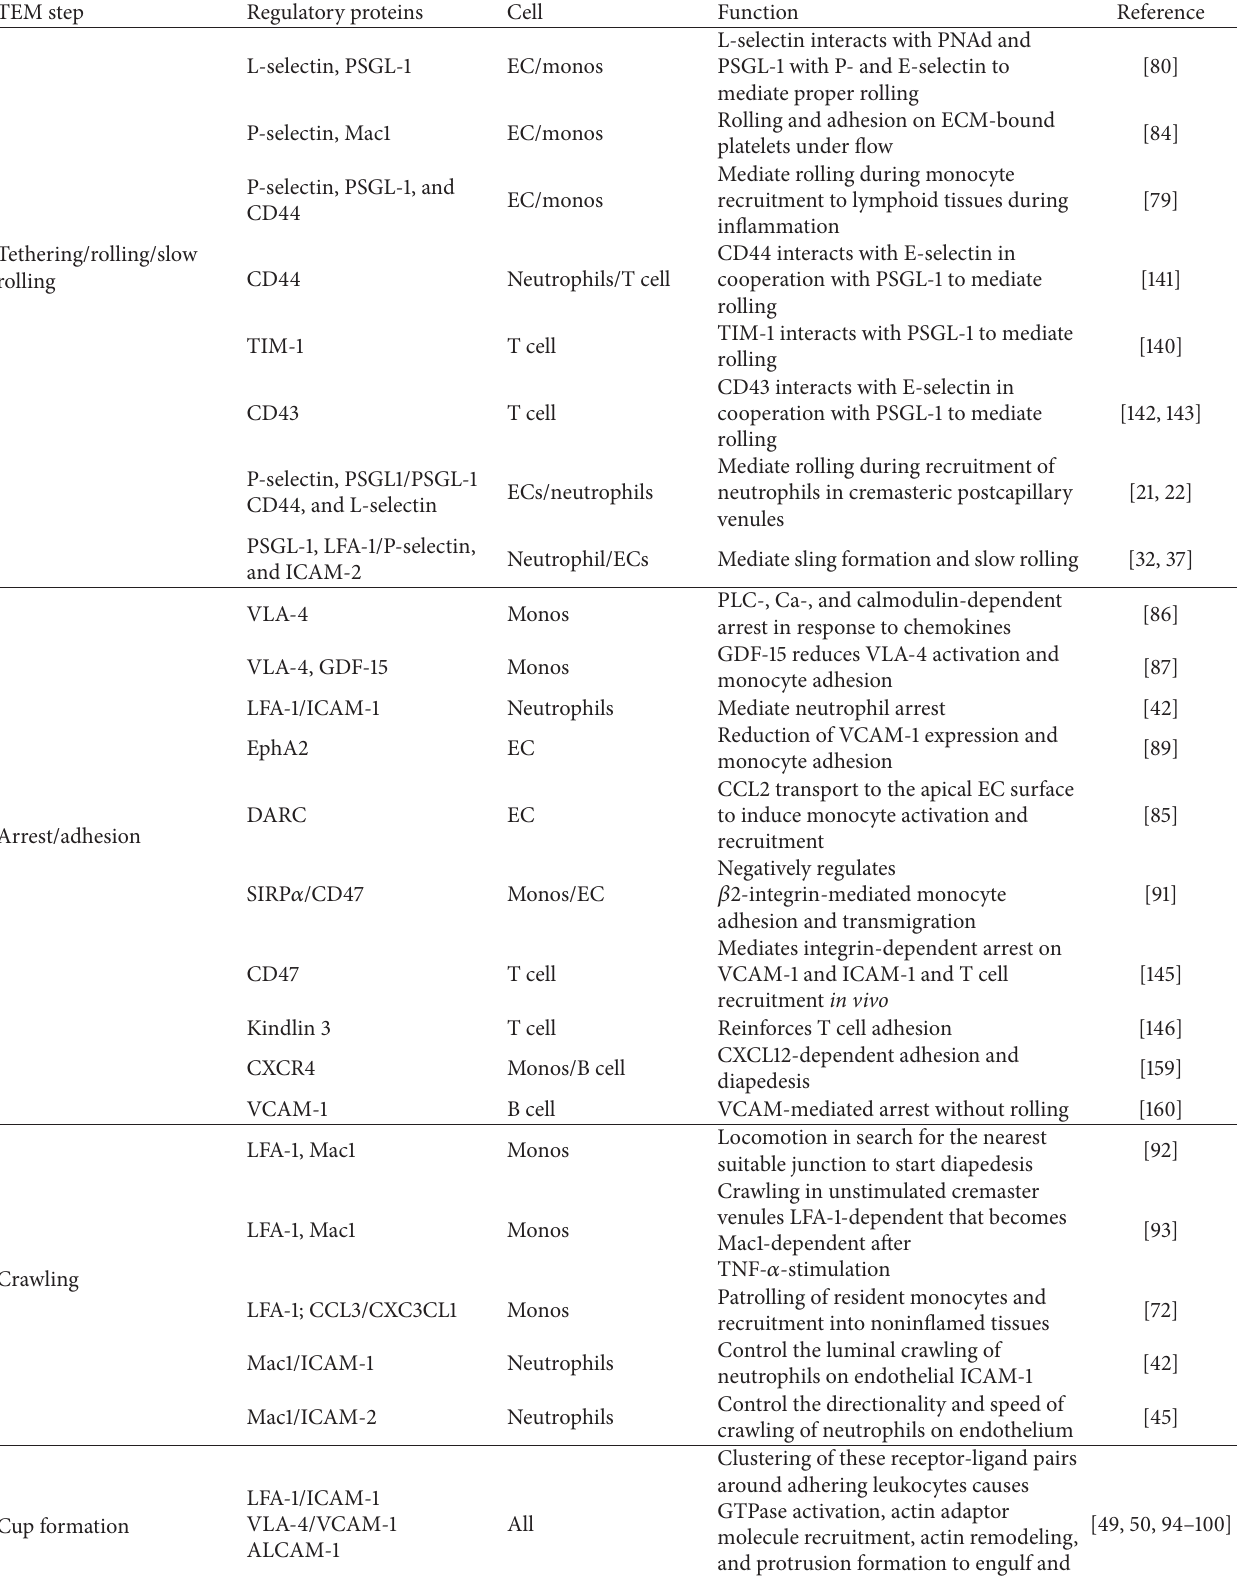
Table 1: Overview of some mechanisms that regulate extravasation of leukocyte subtypes in the order of events during the leukocyte extravasation